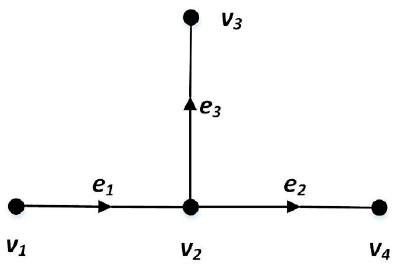
Figure 2. Example of Path.